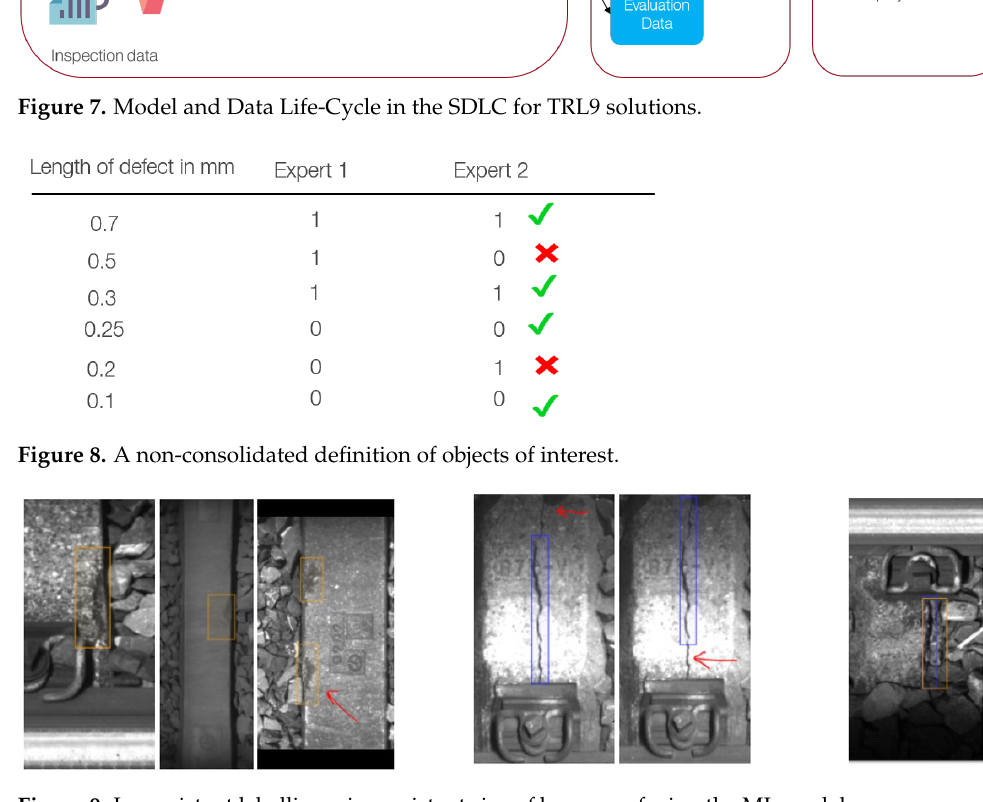
Figure 9. Inconsistent labelling—inconsistent size of boxes confusing the ML